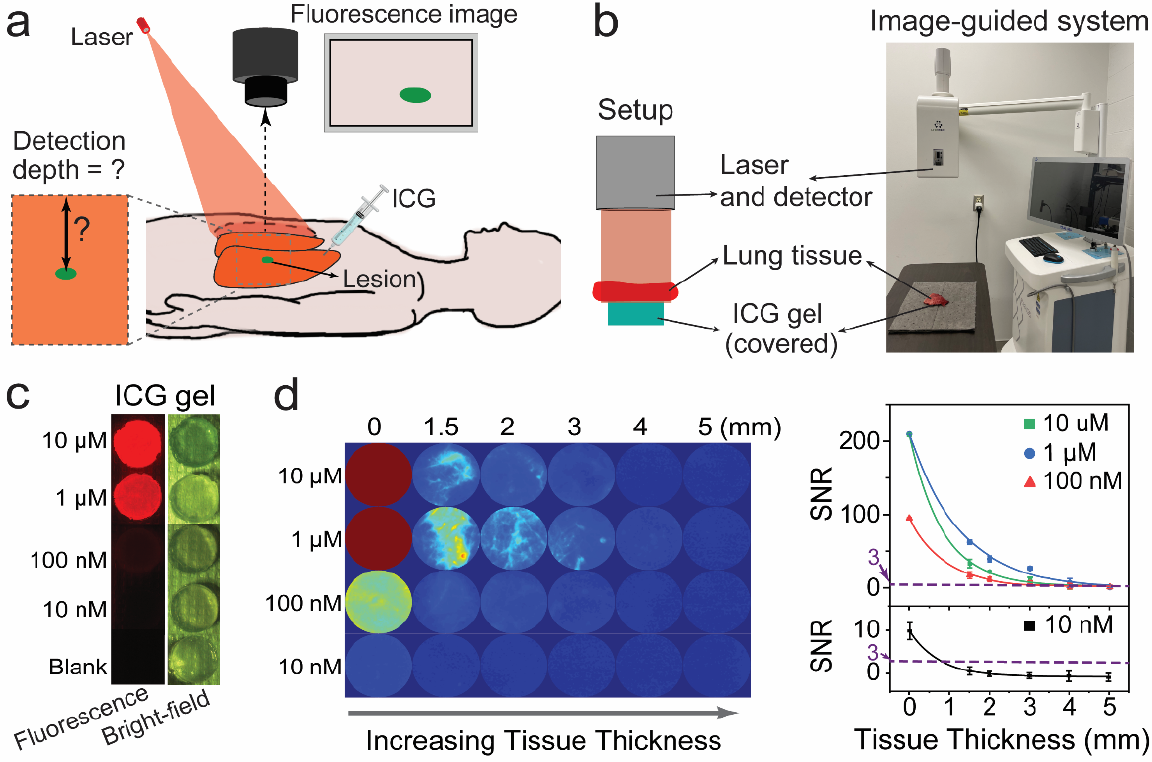
Figure 6. Measurements of the detection depth of fluorescence imaging and spectroscopy in lung tissues. ( a ) Schematic of NIR fluorescence imaging on lung cancer patients. ( b ) The experimental setup. ( c ) Recorded bright and fluorescent images of ICG gels (10 µ M, 1 µ M, 100 nM, 10 nM). ( d ) Fluorescent images and corresponding SBR of ICG gels covered by lung tissues of different thicknesses (0–5 mm).